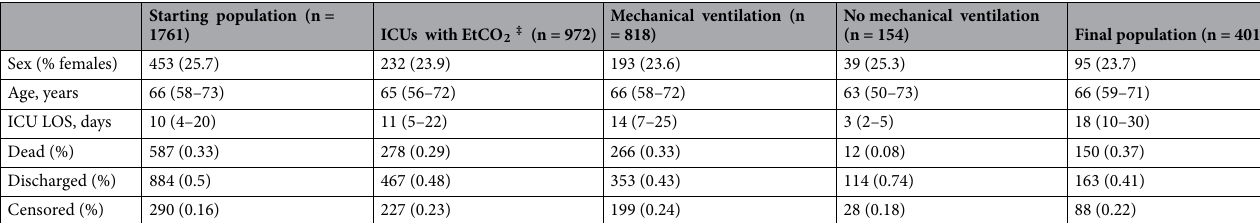
Table 1. Demographic variables and outcomes for the selected populations. Data are median (interquartile range) or numbers (%). Percentages may not total 100 because of rounding. which recorded EtCO 2 in more than 50% of patients. EtCO 2 end-tidal partial pressure of carbon dioxide, ICU intensive care unit, LOS length of